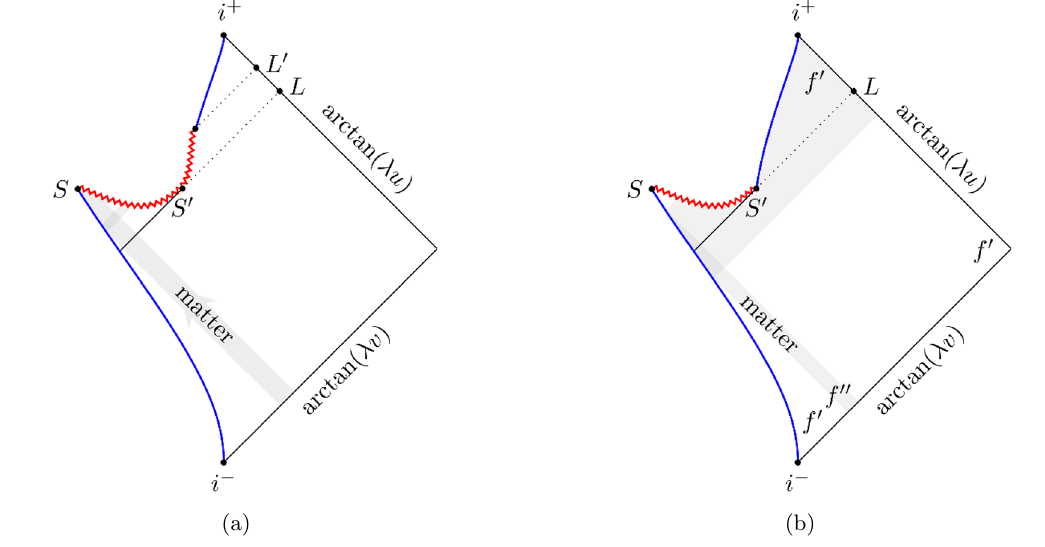
Figure 5 . (a) Smearing the singularity S 0 . (b) Global charge violation in the RST